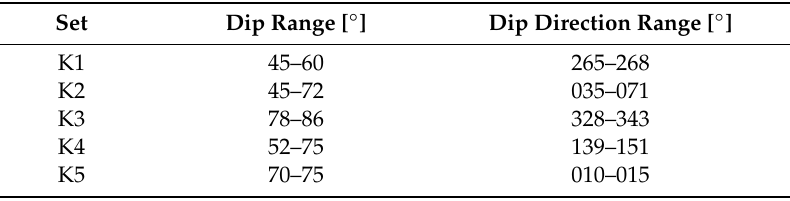
Table 2. Range of variability of main discontinuity sets.